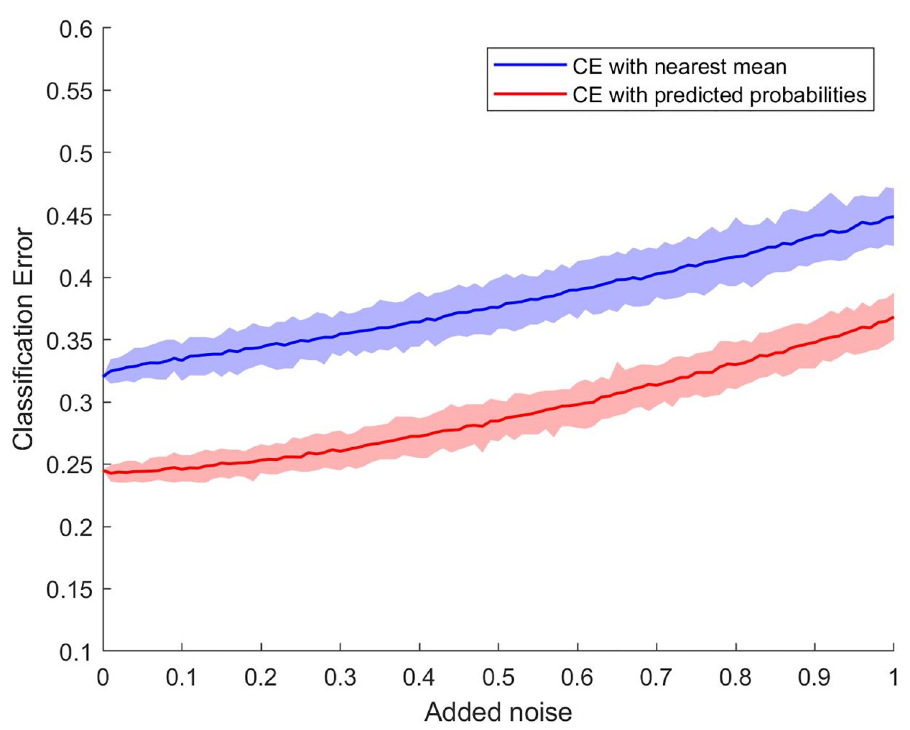
Fig 9. Classification errors for both the nearest mean and logistic regression classifiers as a function of the level of noise added to the data. Average classification errors (dark lines) and their 95% confidence bands for the simulated validation